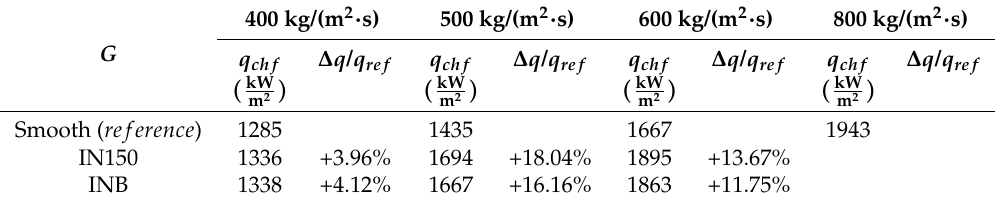
Figure 16. Measured CHF at p out = 200 kPa and T in = 78 °C on four different surfaces in the function of mass flux. Table 10. CHF results of all investigated samples at 200 kPa.